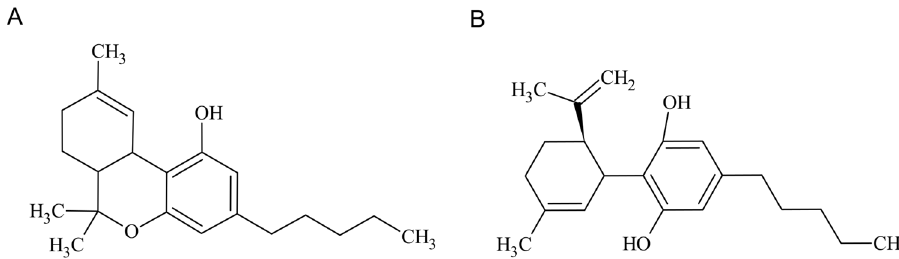
Figure 1. THC ( A ) and CBD ( B ) chemical